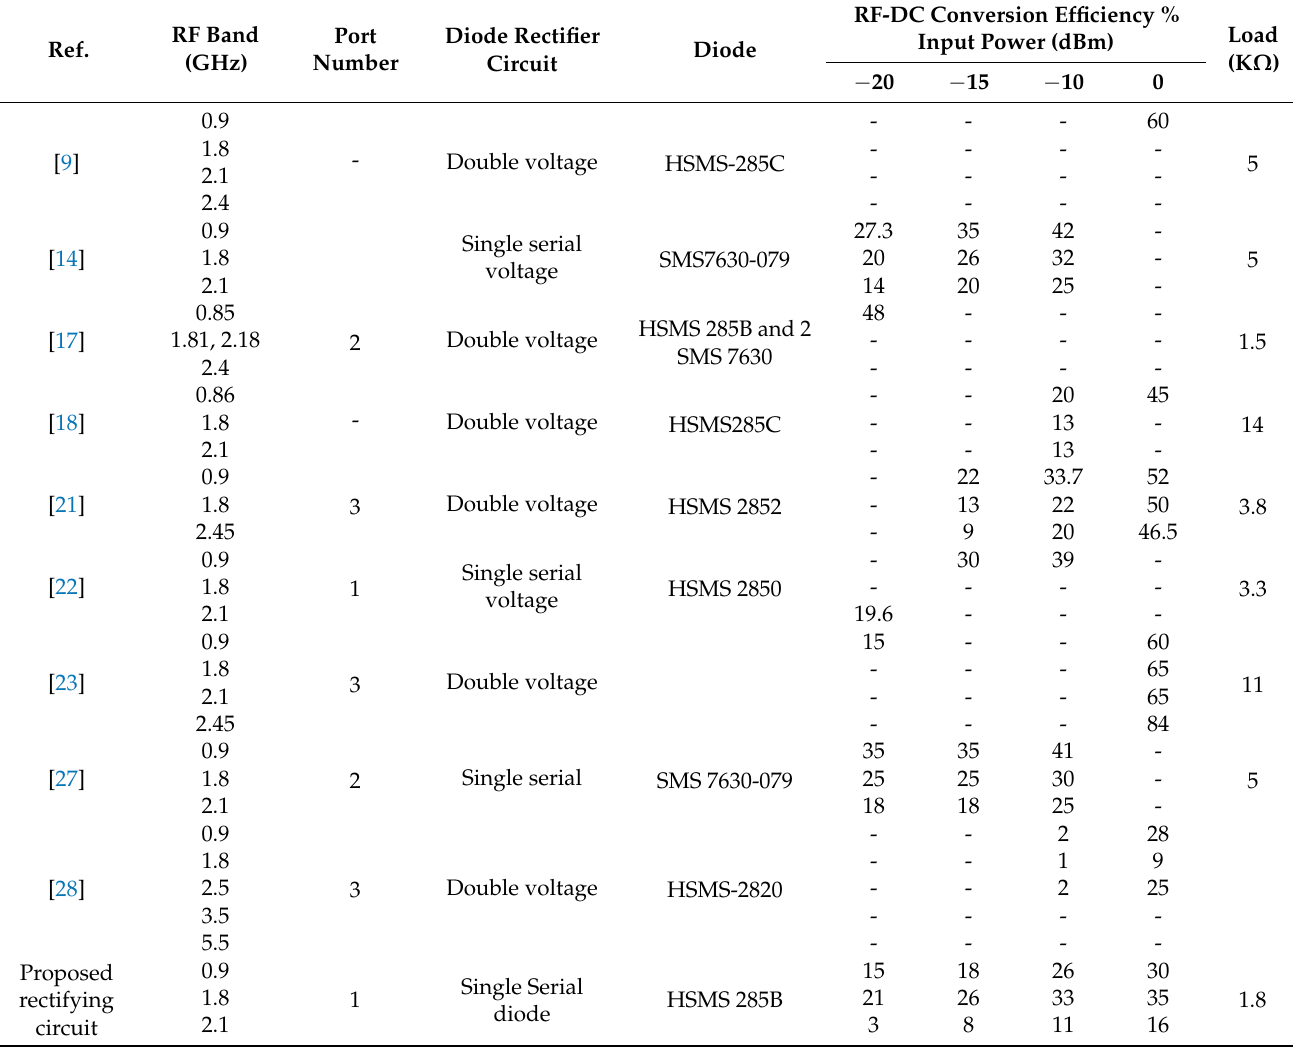
Table 5. Comparative characteristics of the proposed tri-band rectifying circuit against related works.